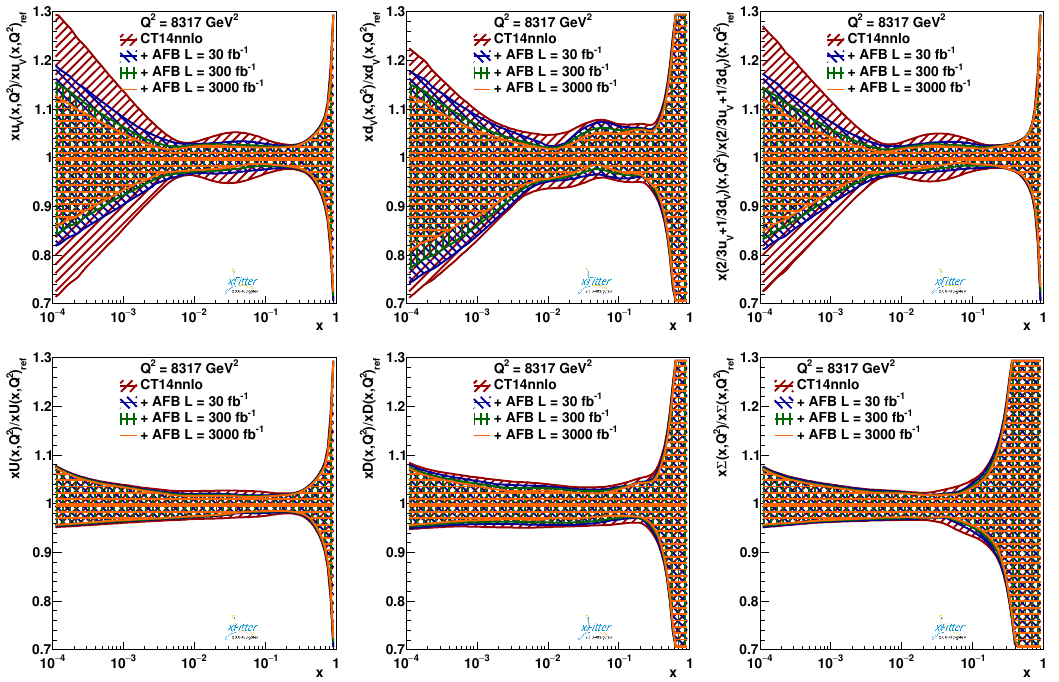
Figure 2 . Original (red) and pro(cid:12)led curves distributions for the normalised distribution of the ratios of (top row, left to right) u -valence, d -valence and ((2 = 3) u + (1 = 3) d )-valence and (bottom row, left to right) u -sea, d -sea quarks and ( u + d )-sea quarks of the CT14nnlo PDF set using A (cid:3) pseudodata corresponding to an integrated luminosity of 30 fb (cid:0) 1 (blue), 300 fb (cid:0) 1 (green) and FB 3000 fb (cid:0) 1